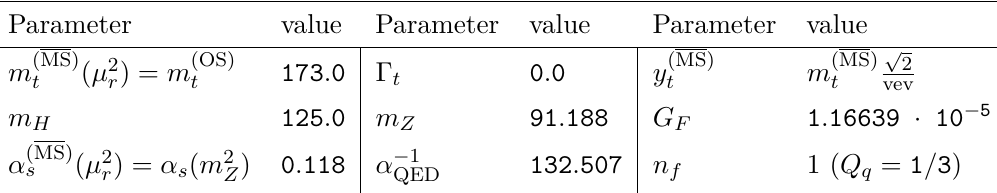
, m ( MS ) and y ( MS ) s t t